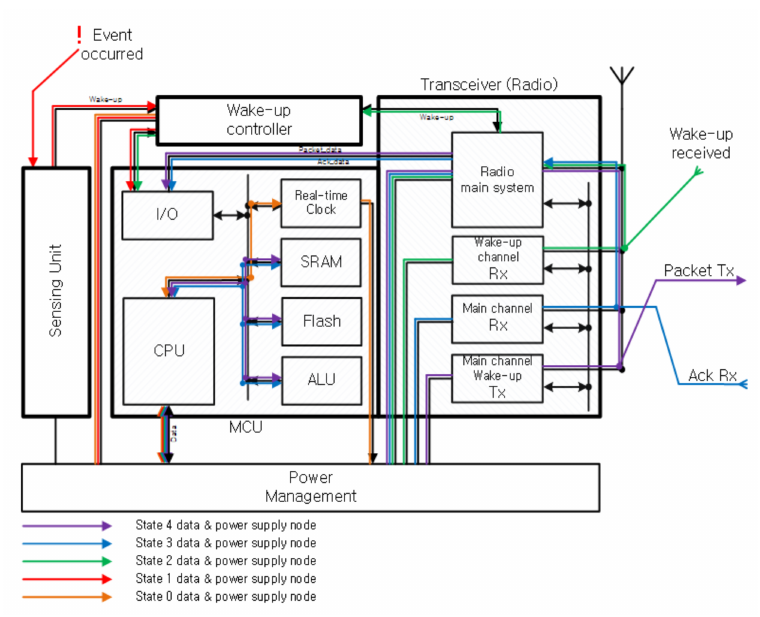
Figure 6. Self-waking paths on the sensor node